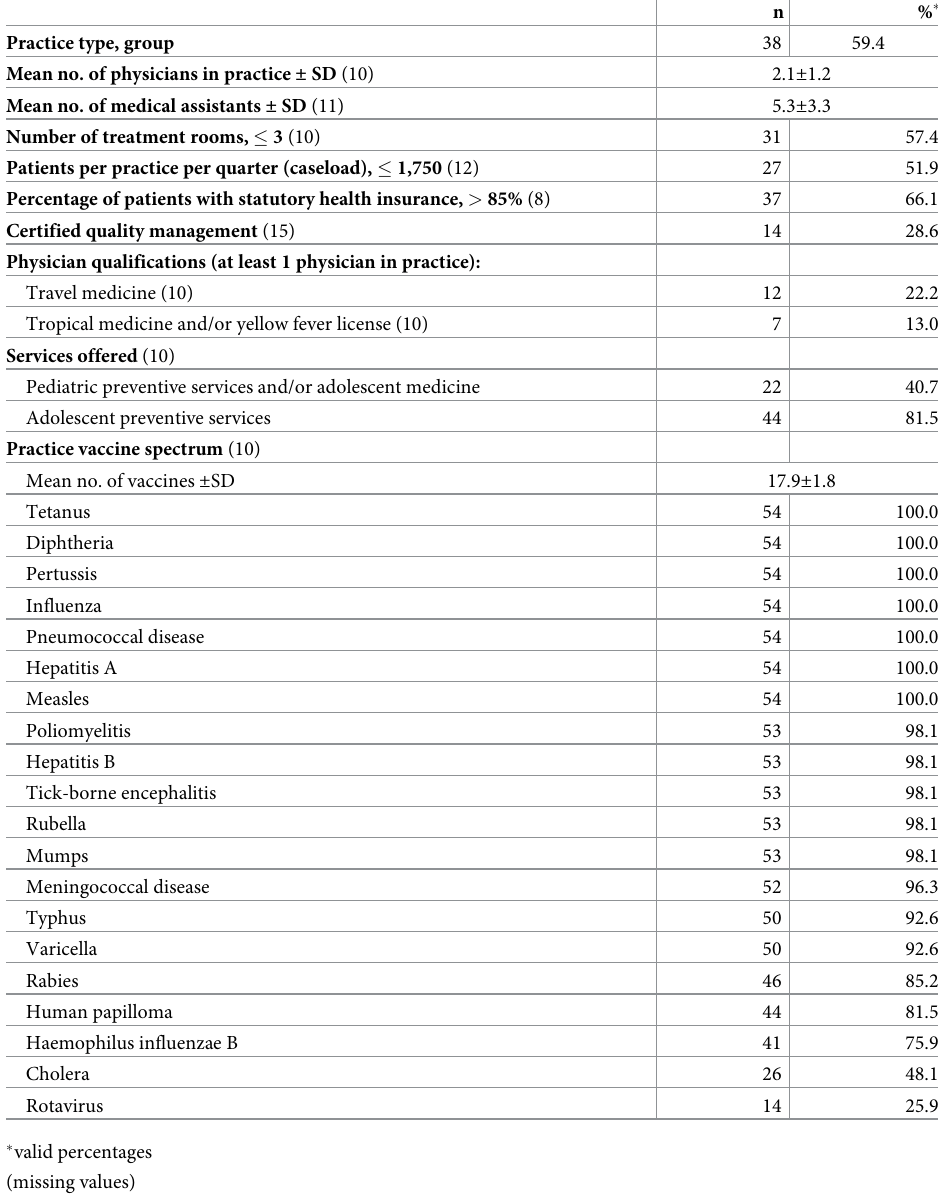
Table 2. Characteristics of participating practices (N =